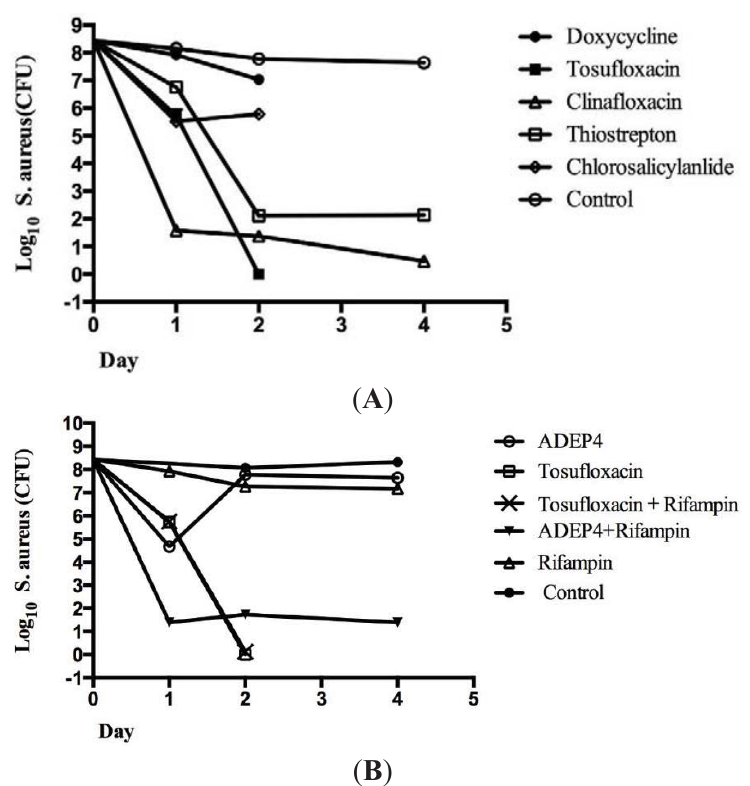
Figure 2. Colony counts to determine the relative activity of the drug candidates and in comparison to known agents active against S. aureus persisters. The S. aureus stationary phase culture was treated with ofloxacin (10 μg/mL) for four hours to enrich persisters. Then, the surviving persisters from the treatment were subjected to drug exposure with different antibiotics (50 μM) as described in the text. The viability of the bacteria was determined by colony forming unit (CFU) count 1 to 4 days after drug exposure. ( A ) Tosufloxacin (50 μM) was the most active among the six drugs, and completely eliminated all persisters after 2 days; ( B ) acyldepsipeptide (ADEP4) + rifampin (RIF) could not completely eradicate S. aureus persisters even after 4 days. The final concentrations of ADEP4 and RIF were 5 μg/mL and 0.4 μg/mL,